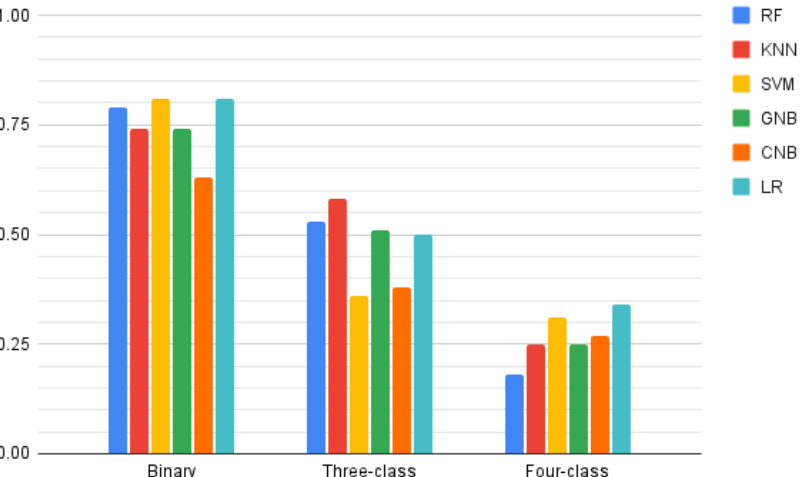
Figure 2. F1-scores for each Modified Fatigue Impact Scale-cognitive classification type (binary, 3-classes, and 4-classes) on each model evaluated: random forest (RF), K-nearest neighbors (KNN), support vector machine (SVM), Gaussian naive Bayes (GNB), complement naive Bayes (CNB), and logistic regression (LR).